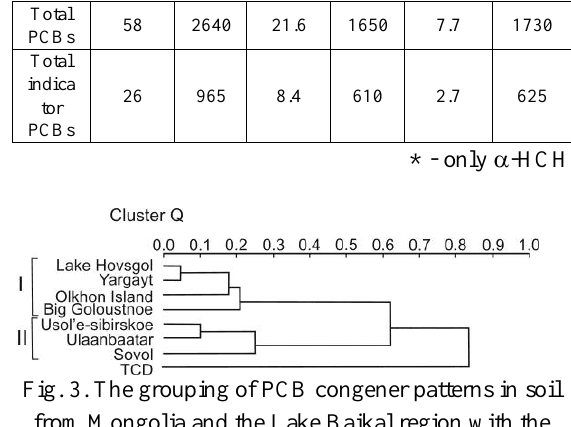
Fig. 3. The grouping of PCB congener patterns in soil from Mongolia and the Lake Baikal region with the cluster